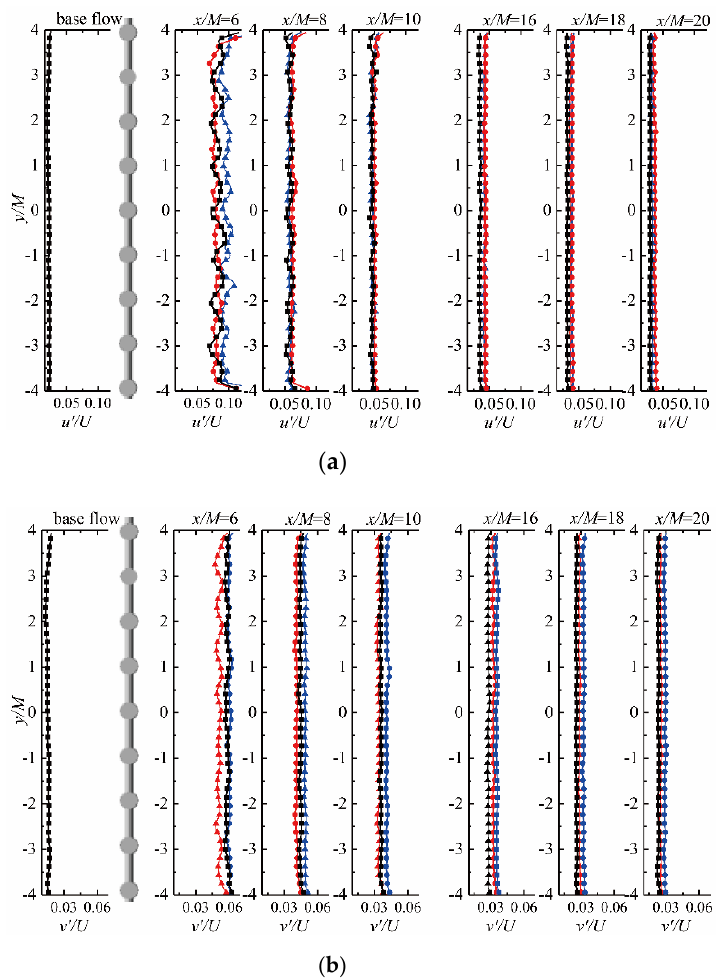
Figure 5. Horizontal distribution of turbulence intensities ( a ) stream-wise components ( u’ / U ); ( b ) transverse components ( v’ / U ); red (1/3 depth), black (mid-depth), blue (2/3 depth).